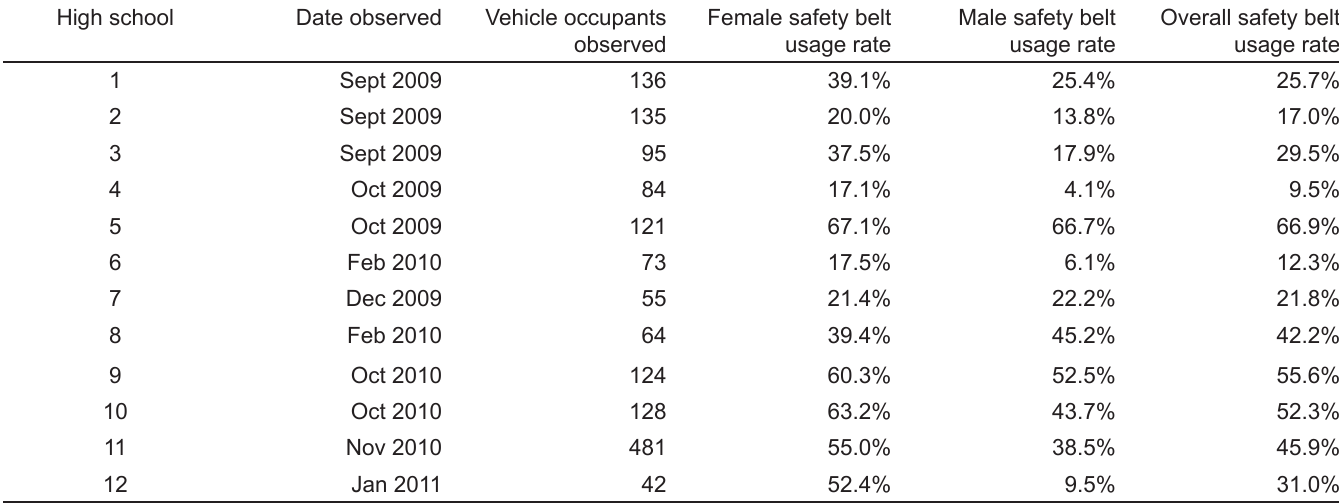
Table 2 . Observational survey results with 1,538 vehicle